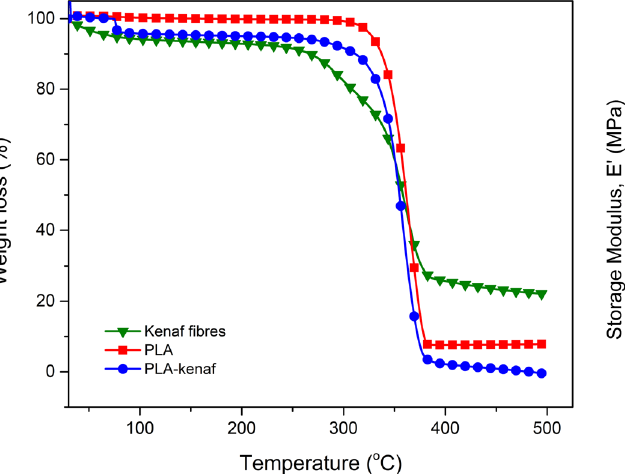
Figure 4: Storage modulus of pure PLA and the UD PLA – kenaf composite with a 0° fi ber orientation.